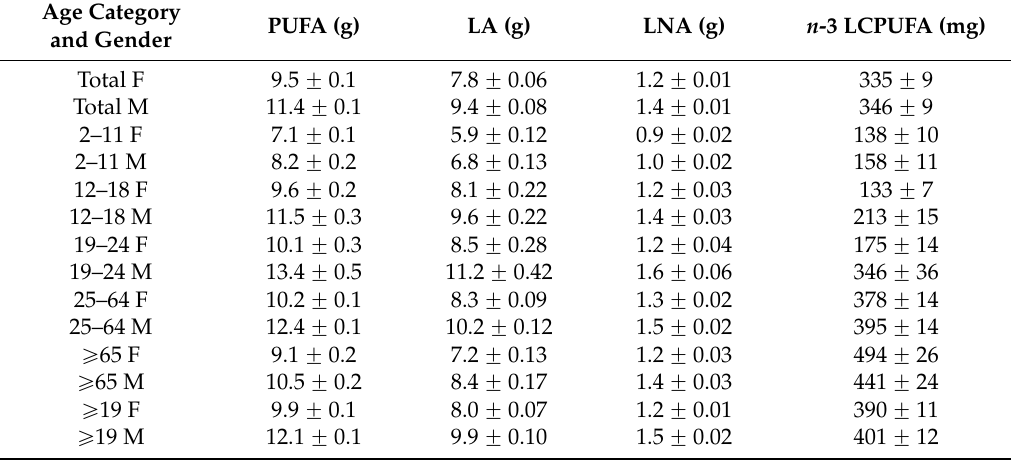
Table 2. 2011–2012 NNPAS polyunsaturated fatty acids (PUFA), linoleic acid (LA), whilst 2011–2012 NNPAS polyunsaturated fatty acids (PUFA), linoleic acid (LA), whilst SEM). alpha-linolenic acid (LNA) and the n -3 long-chain PUFA ( n -3 LCPUFA) intakes per day (mean ˘ SEM).